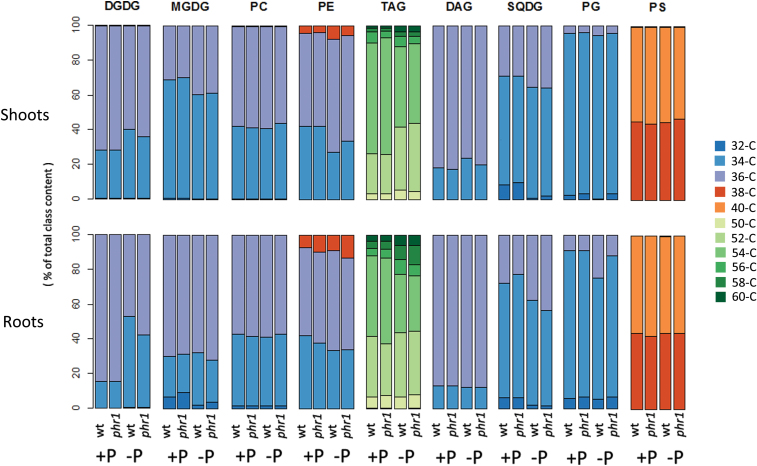
P starvation changes the composition of glycerolipid classes. Values show the percentage contribution of the different acyl groups (groups of lipid species with the same number of acyl carbons) to the total class content, the sum of the normalized intensities of all the compounds belonging to the same class.